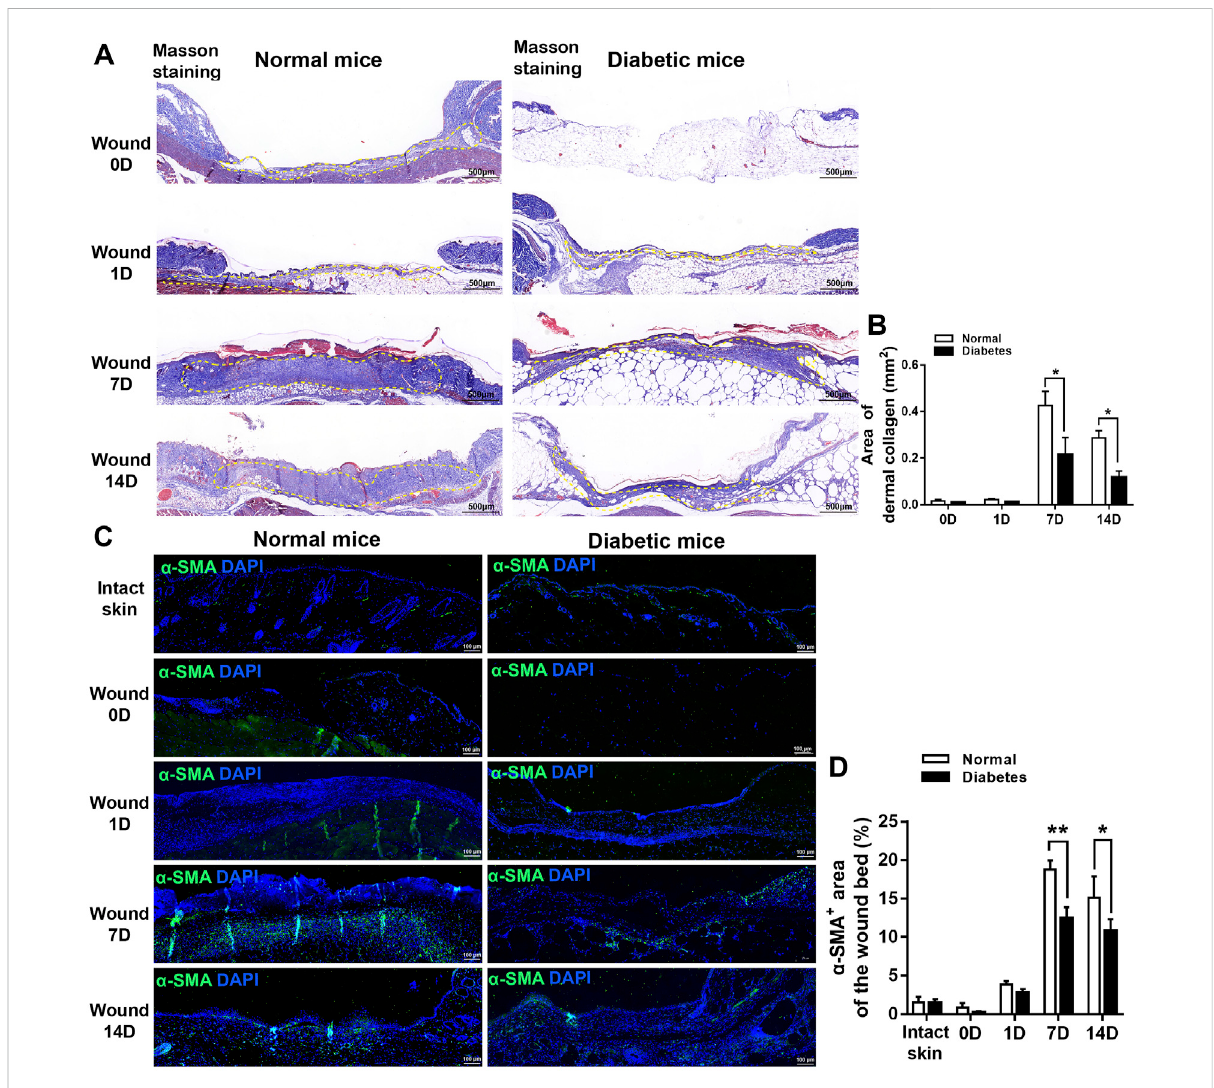
FIGURE 3 Diabetes impairs myo fi broblast formation during cutaneous wound healing. (A) Representative images of Masson ’ s trichrome-stained sections of normal and diabetic wounds. (B) Measurementof the area ofdermal collagen at days 0, 1, 7, and 14 post-wounding. The yellow dotted lines show the dermal collagen. (C) Representative immuno fl uorescence analyses of α -SMA expression in sections of normal and diabetic wounds. (D) Measurement of the α -SMA + area in intact skin and in the wound bed at days 0, 1, 7, and 14 post-wounding. Data are presented as mean ± SD, ** p < .01 and* p < .05, n = 6/group, two-way ANOVA, Bonferroni ’ s post hoc